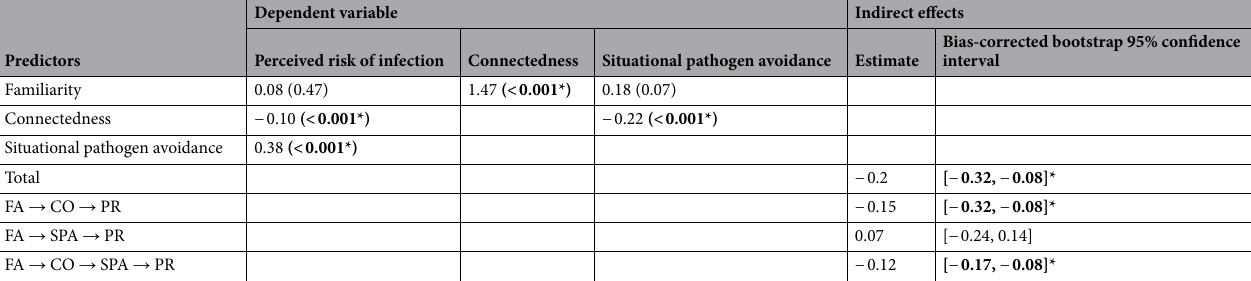
Table 1. Mediation analyses model 1. In Study 1, two mediation models with two mediators (connectedness and disgust) were calculated. Mediation model 1 refers to the outcome variable perceived risk of infection. Table 1 shows the direct effects (β) in the mediation models and the indirect effects in mediation model 1. p-values less than 0.05 are assumed to be significant (*). An indirect effect is assumed as significant if the 95% CI does not include 0